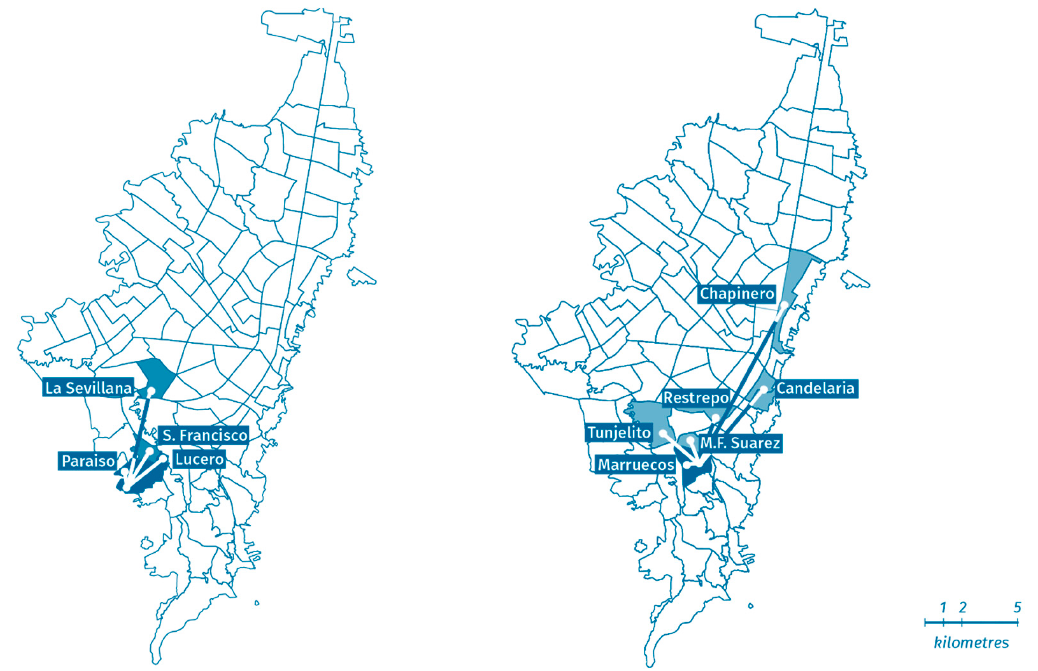
Figure 4. Principal areas of interaction for the neighbourhoods of La Torre ( left ) and La Merced del Sur ( right ) (source: [50]).